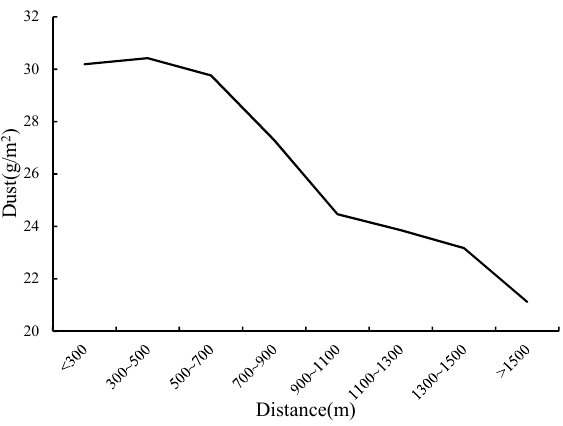
Figure 8. Variation in canopy dust retention content with distance to the mining area.